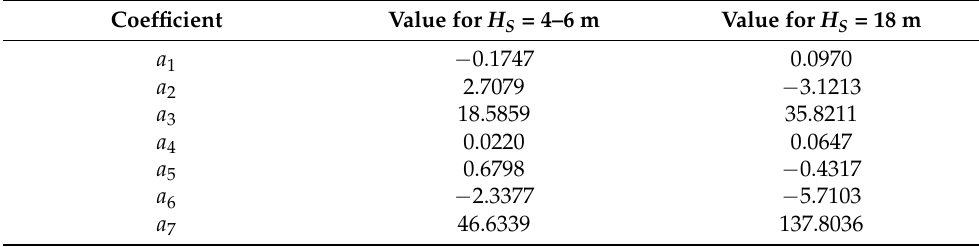
Table 1. Coefficients of the expression approximating the clutter loss statistics for H s = 4–6 m and 18